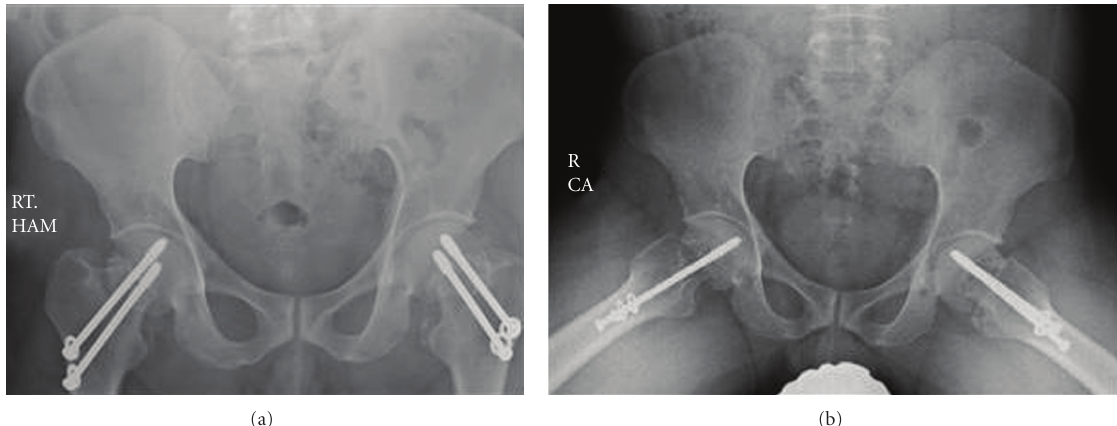
Figure 3: Postfixation of fracture neck of